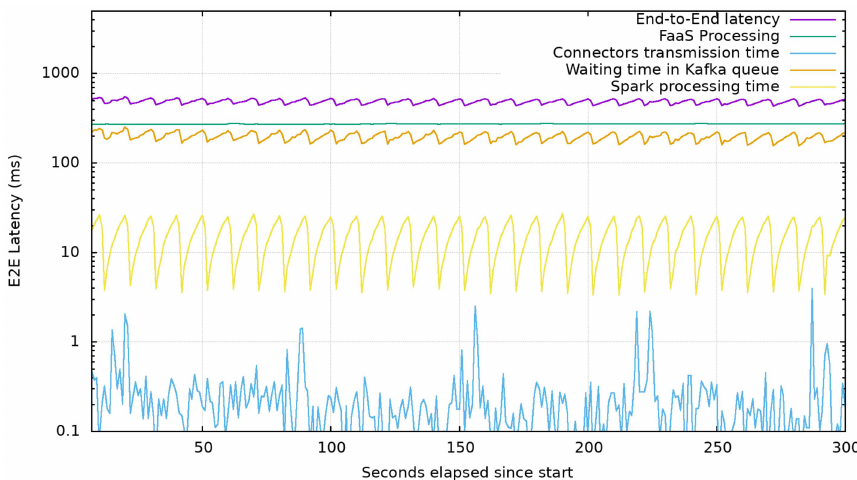
Figure 7. Average latency introduced by each component compared with the end-to-end latency when under a constant load of 1000 message/s (Log